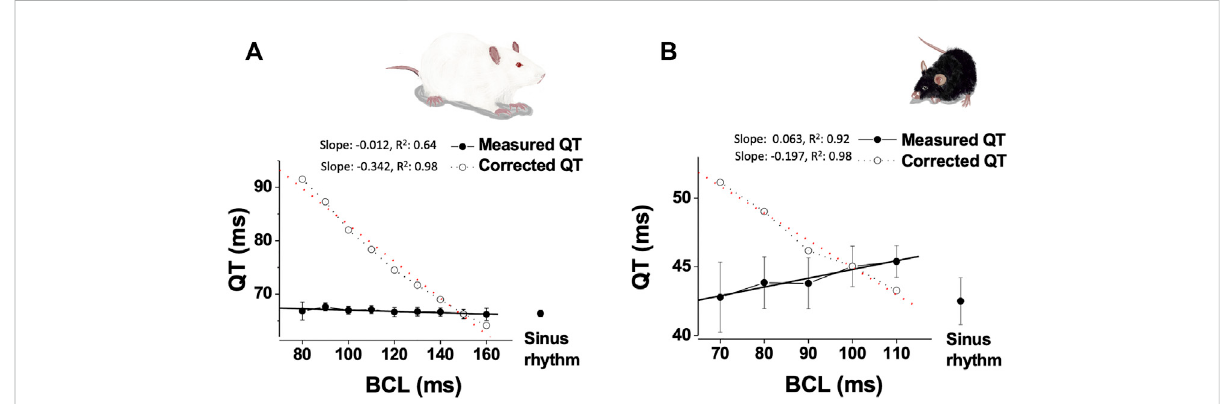
FIGURE 1 Absence of QT interval dependence on HR in paced unanesthetized rodents. (A) . Data from instrumented, unanesthetized male SD rats that weresubjectedtoatrialpacing atdifferentCL( n =10):Mean±SEofmeasuredQTandcalculatedQTc(basedontheformulaofKmecovaandKlimas (Kmecova and Klimas, 2010)), plotted as a function of CL. Linear regression data (slope, R 2 ) are presented for both QT and calculated QTc. (B) . Data from instrumented, unanesthetized male C57BL/J mice that were subjected to atrial pacing at different CL ( n = 9): Mean ± SE of measured QT and calculated QTc [based on the formula of Mitchell et al. (1998)], plotted as a function of CL. Linear regression data (slope, R 2 ) are presented for both QT and calculated QTc. Experimental fi ndings were adapted from Mulla et al.